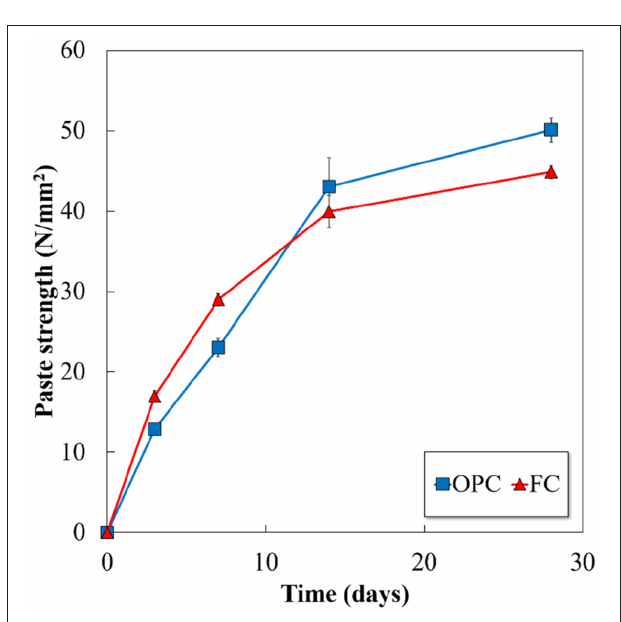
FIGURE 6 | Compressive strength of hydrated